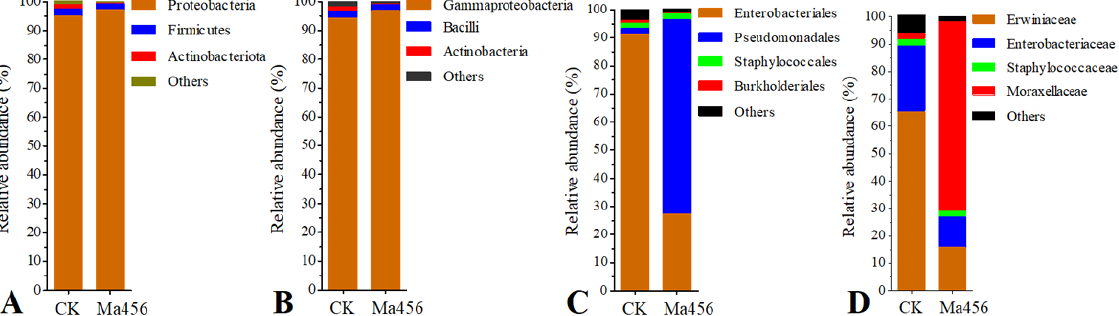
Figure 3. The bacteria with the relative abundance over 1.00% in at least one BPH population at the levels of phylum ( A ), class ( B ), order ( C ) and family ( D ) in the gut of BPH that treated by fungal infection (Ma456) and 0.02% Tween 80 (CK), respectively.